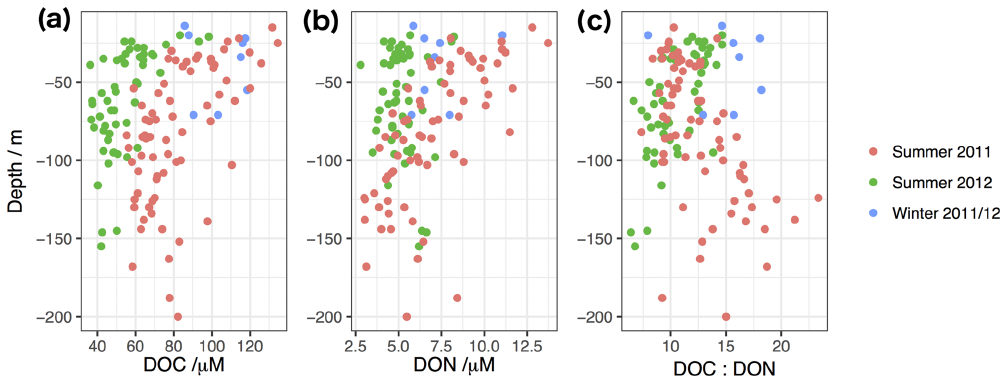
Figure 8. DOC (a) , DON (b) and DOM carbon-to-nitrogen ratios (c) in bottom water samples, plotted against sampling depth (approximately 10m less than total water column depth). Red points from summer 2011, green points from summer 2012, blue from the intervening winter